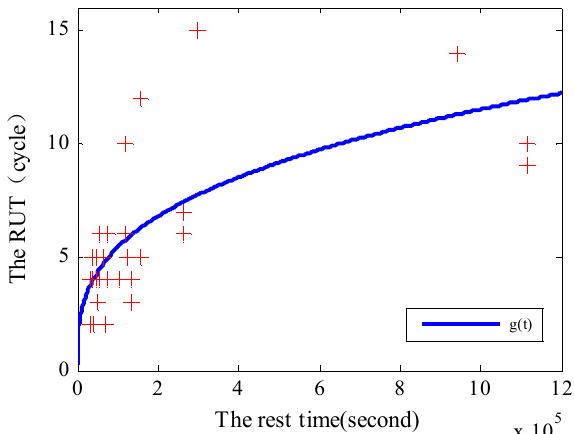
Figure 7. The relationship function ( ) g t between the rest time and the RUT.